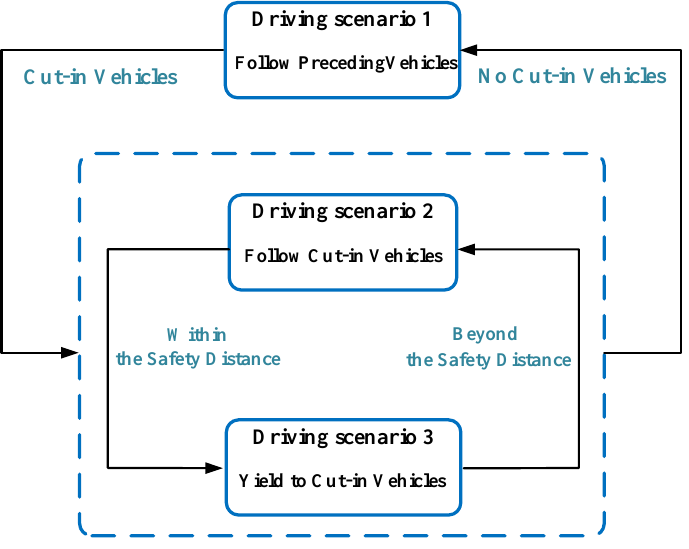
Figure 2. Scenarios division.